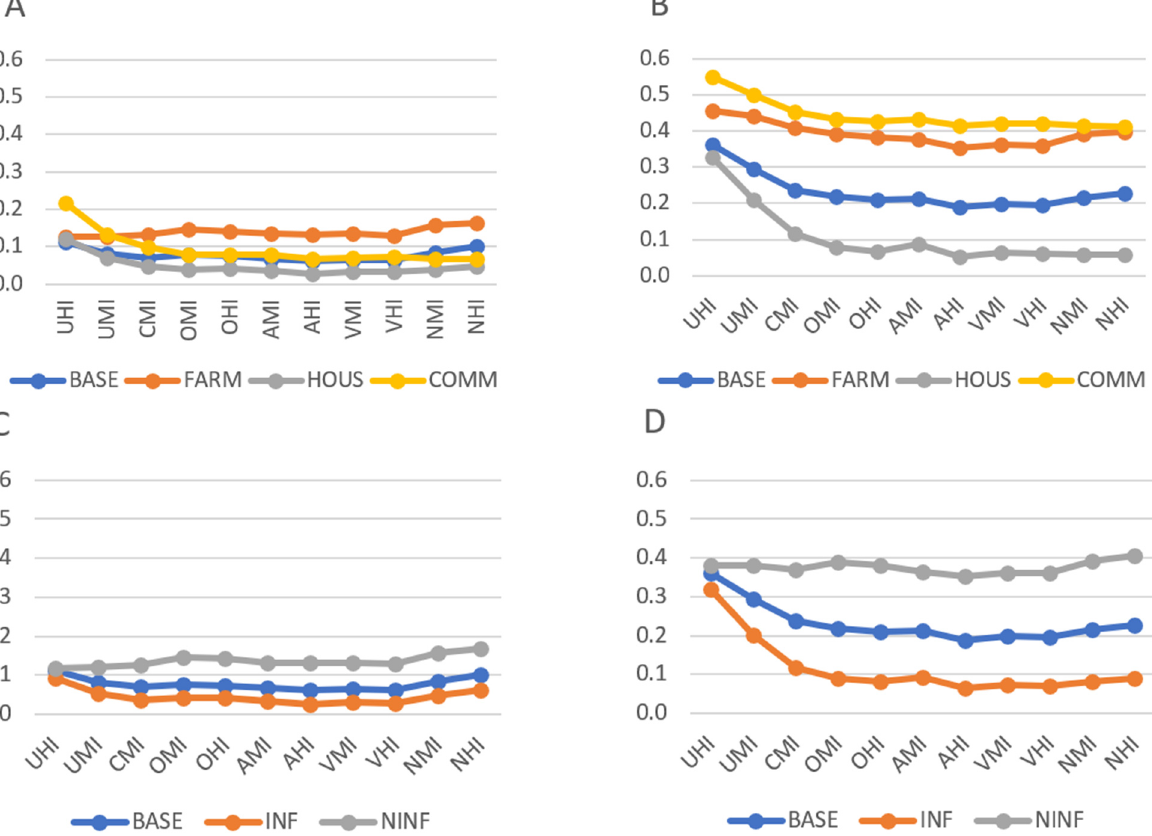
Figure 5. Graphs of mean suitability values in the various landscape classes (landscape codes are described in Table 1 and scenario codes in Table 2). ( A , B ): economic perspective, ( C , D ): infrastructure perspective. ( A , C ): supply-based suitability, ( B , D ): demand-based suitability.